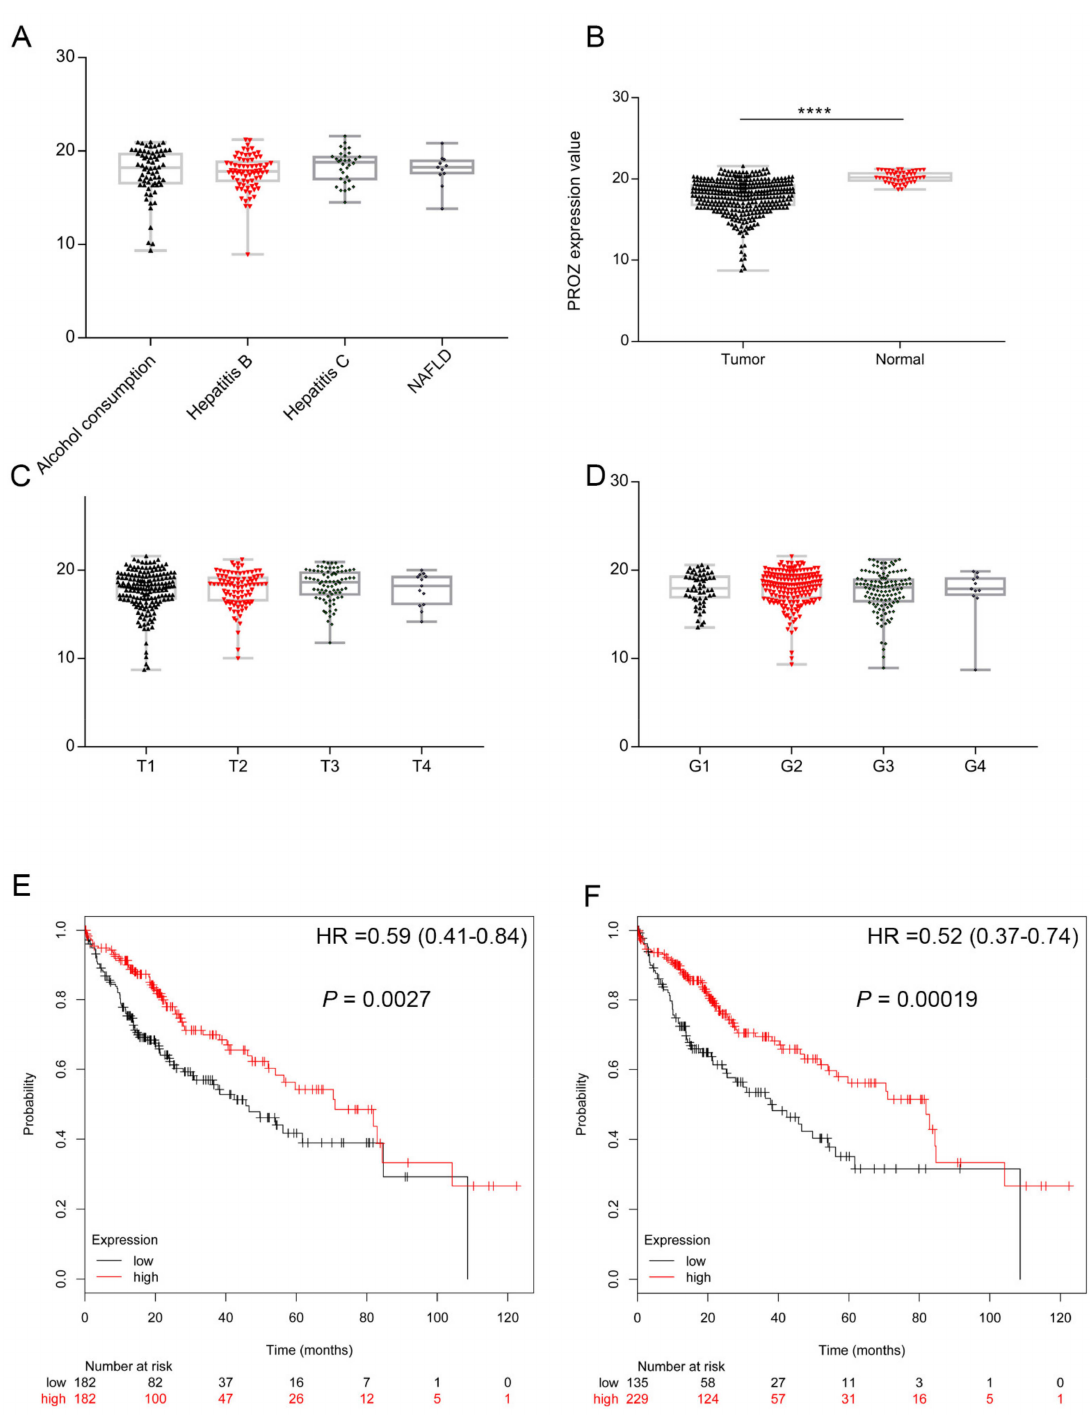
Figure 2. ( A ) Expression of PROZ in tumor tissues with different underlying diseases. ( B ) Expression of PROZ differed by tumor or normal tissue. Expression of PROZ differed in cancer with different T stage ( C ) and histological grade ( D ). Kaplan–Meier curve analysis shows the overall survival in patients with HCC showing high and low PROZ expression, the expression of PROZ in HCC was divided into two groups equally ( E ) or divided into two groups with the optimal node ( F ) in TCGA cohorts (**** p <